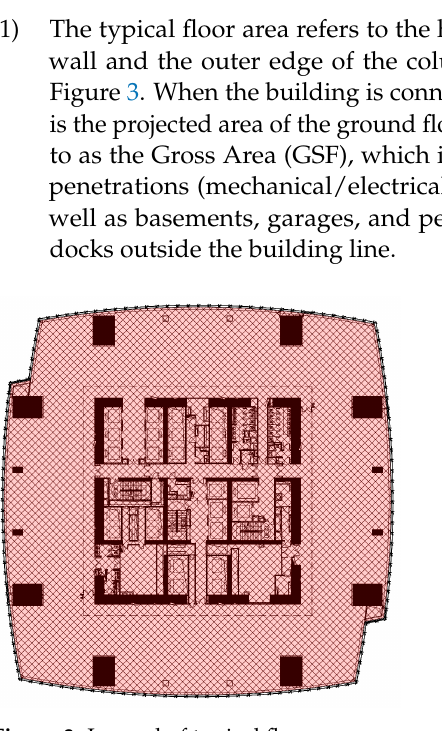
Figure 3. Legend of typical floor area.